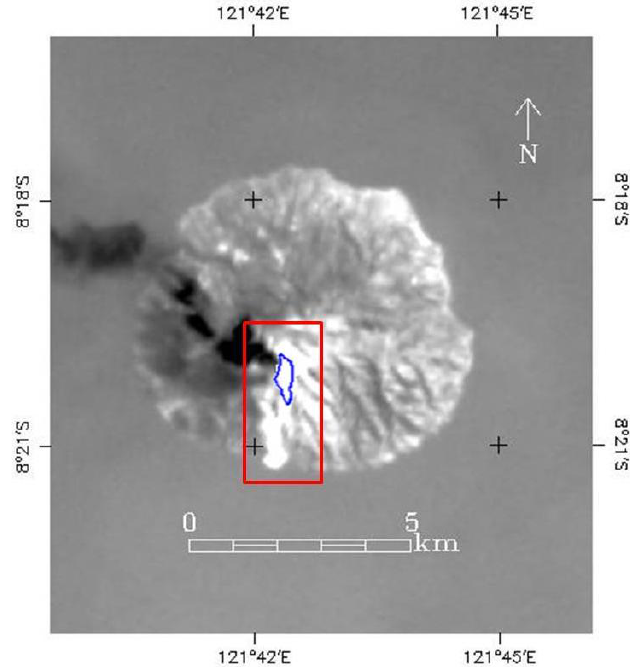
Figure 1. Landsat-8 band 10 image of Paluweh Volcano on 29 April 2013. The volcano forms an island in the Flores Sea to the north of the Indonesia island of Flores. Evident here are bright regions to the centre and south of the landform which constitute the thermally anomalous activity at the volcano. To the west, the plume emanating from the volcano can be seen as a darker (cooler) region. The rectangular region outlined in red is that which was extracted for analysis. It encompasses the anomalous volcanic radiant signals, here outlined in blue, and also a portion of the non-volcanically active surroundings and a small part of the associated ash plume. Image source: